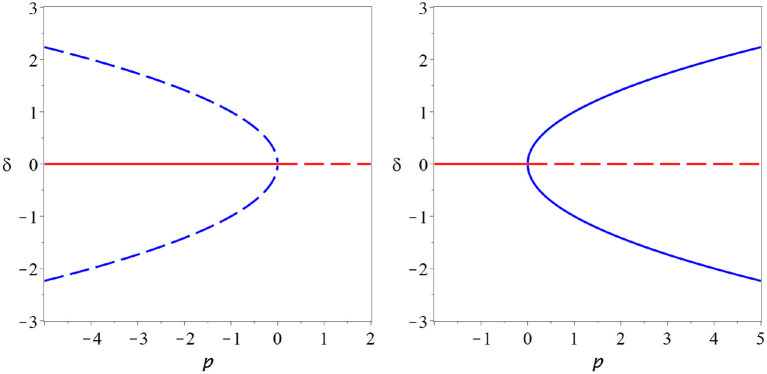
Pitchfork bifurcation. In this bifurcation a steady state (red) loses stability as either two additional branches of steady states (blue dashed) are destroyed (subcritical case, left) or two branches of stable steady states (blue solid) emerge (supercritical, right). A system could plausibly operate at a supercritical pitchfork and profit from persistent memory and super-sensitivity that this bifurcation conveys. However, the pitchfork bifurcation requires a special symmetry that is hard to motivate for the brain, it therefore is an unlikely candidate for the operating point of neural criticality.